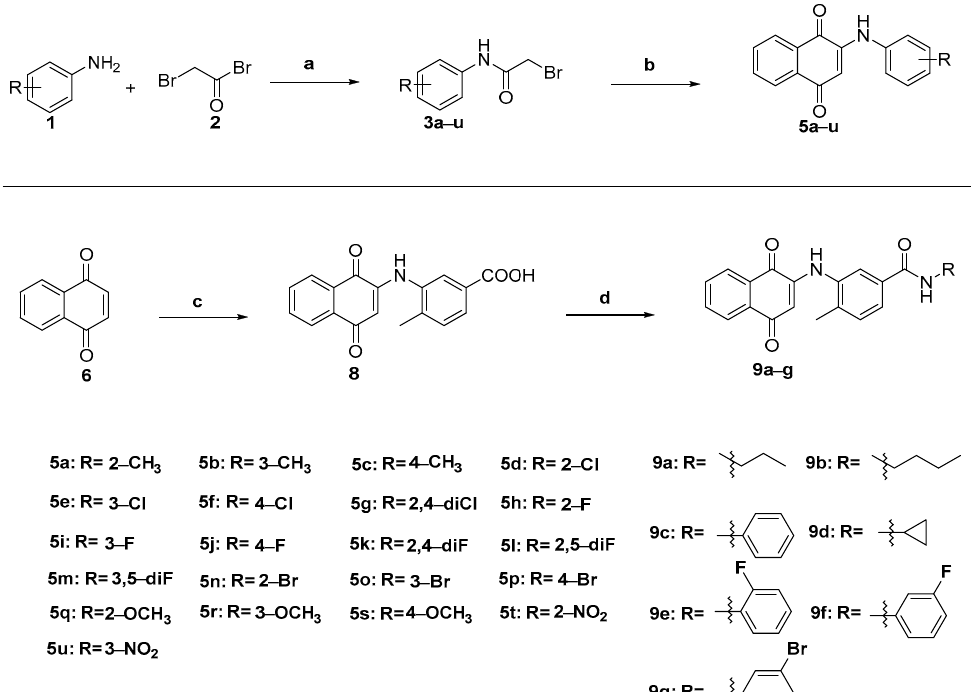
Figure 2. Synthetic route of target molecules. Reagents and conditions. (a) K 2 CO 3 and DCM (Dichloromethane) at room temperature. (b) 2-Hydroxy-1,4-naphthoquinone, Cs 2 CO 3 , and DMF at room temperature. (c) 3-amino-p-toluidic acid, Cu(OAc) 2 , and AcOH at 60–70 °C. (d) Different substitution of fatty amines and aromatic amines, HATU, Dipea, and DCM at room temperature.